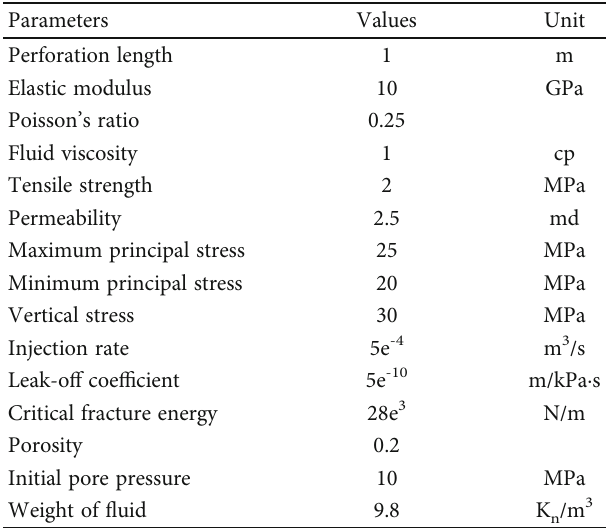
Table 1: Input parameters for the numerical